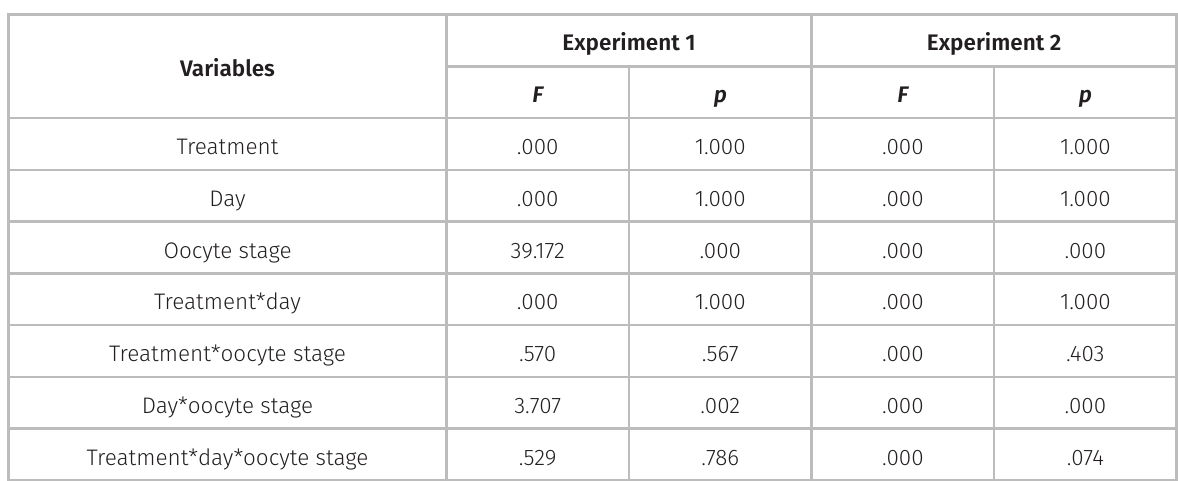
Table I. Area (%) occupied by the different developmental oocytes stages in the ovaries of Macrobrachium acanthurus both in ablated/non-ablated females assigned on different monitoring days (1, 3, 5 and 7) of experiments 1 and 2 (F- and p-